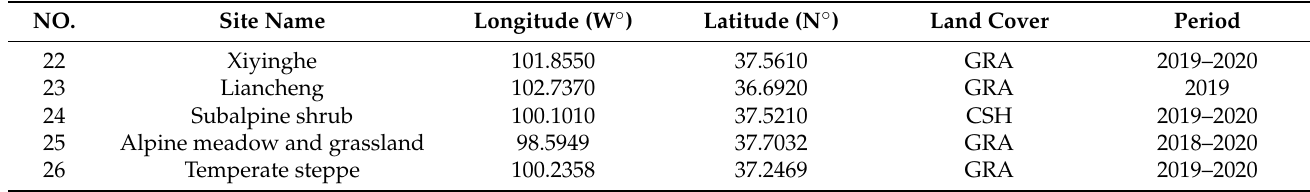
Table 2. Information of the sites in Qilian Mountains integrated observatory network.